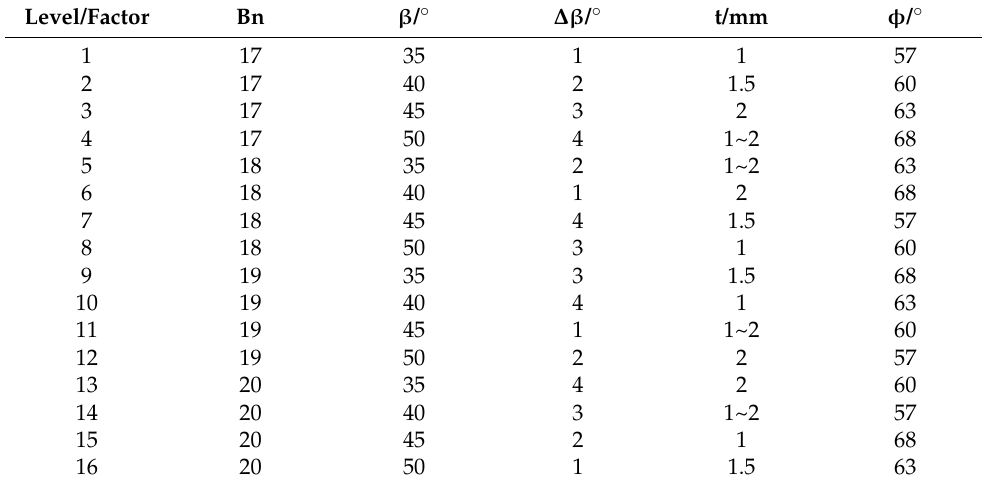
Table 5. Orthogonal